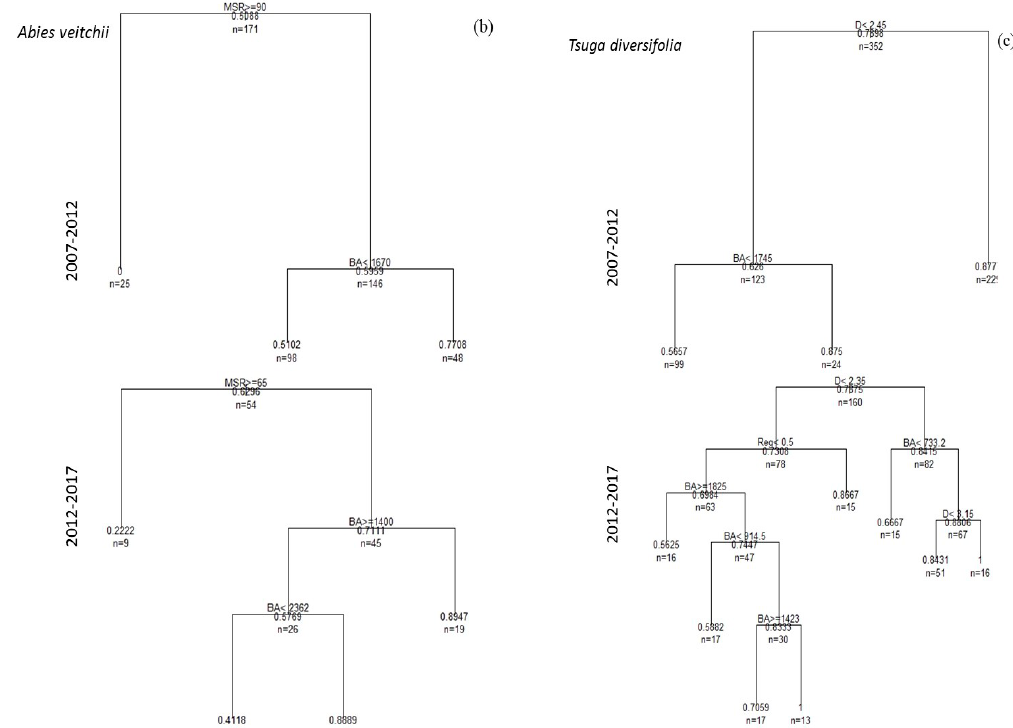
Figure 4. Results of tree regression models drawn to clarify the factors a ff ecting survivorship of saplings of the three conifer species. At the first node, the first line gives the most influential factor a ff ecting the survival and the threshold values. Threshold values of the explanatory variables recursively divide the data into homogeneous clusters at each node, according to whether they meet the criterion (death to the left and survive to the right). MSR—maximum bark stripping ratio; BA—basal area; D—diameter at breast height; Reg—regeneration mode. ( a ) Abies mariesii , ( b ) Abies vetichii , ( c ) Tsuga diversifolia.